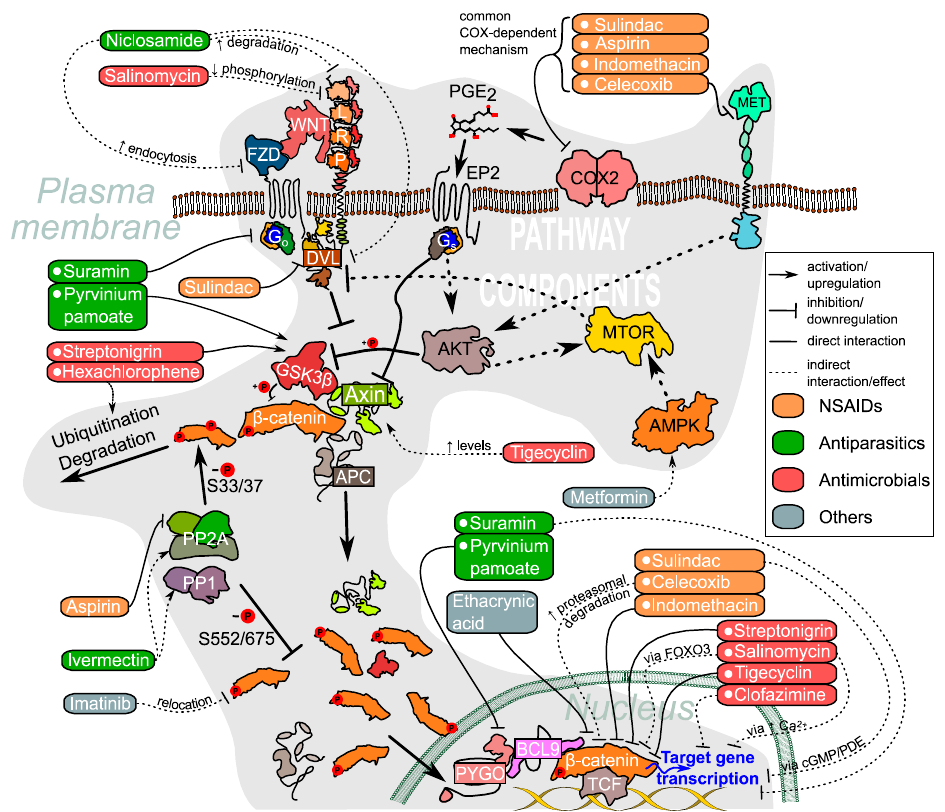
Figure 1. Targets of approved drugs in the context of WNT and related pathways. For